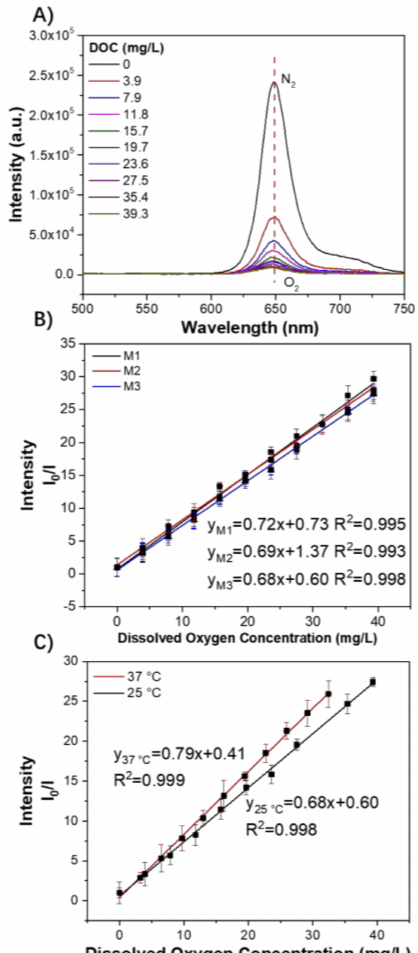
Figure 5. ( A ): Oxygen responses of the micelles excited at 405 nm; ( B ): Stern–Volmer plots of micelles M1 – M3 by using the oxygen probe’s emission intensities at 650 nm; ( C ): Stern–Volmer plots of micelles M3 at 25 ◦ C and 37 ◦ C. I 0 is the intensity under nitrogen; I is the intensity under oxygen. The changes in the lifetimes of PtTFPP in micelles were also measured at room temperature under nitrogen and air conditions (Figure 6). Under air condition, the three micelles’ lifetimes are 7.64 to 7.93 µ s for M1 , M2 , and M3 , which were slightly a ff ected by the micellar structures. Under nitrogen conditions, the di ff erences of lifetimes among the three micelles are much more obvious; those are 23.65, 28.02 and 35.98 µ s for M1 , M2 , and M3 ,